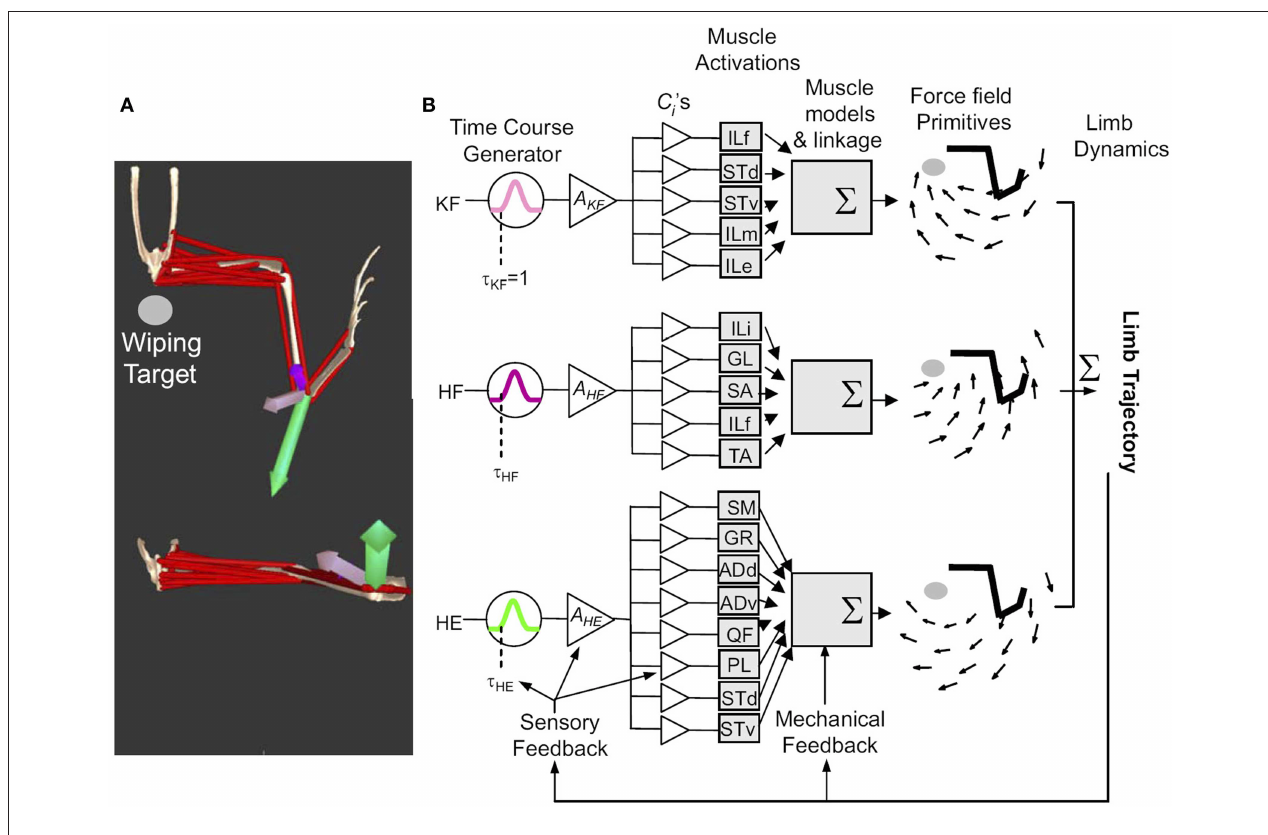
HF) comprise pulsed activation of drives (e.g., time course τ KF , peak activation A KF ) which activate muscles in balances given by the fixed c i , determined by the interneuron drive projections. Individual muscle